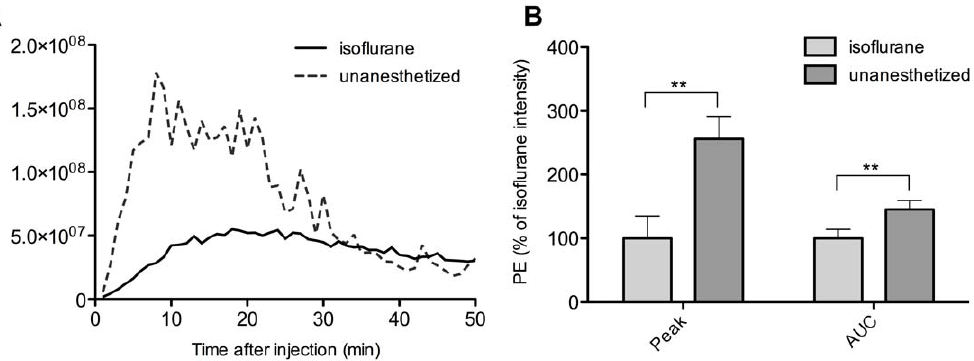
Figure 7. Comparison of peak signal and AUC of the signal for isoflurane-anesthetized and unanesthetized mice. ( A ) shows a representative example of the time profile obtained using isoflurane anesthesia (full line) and without anesthesia (dotted line). ( B ) shows the average peak signal and AUC of the signal for the same mice, anesthetized with isoflurane or without anesthesia. ** p , 0.01 between indicated conditions. AUC area under the curve .